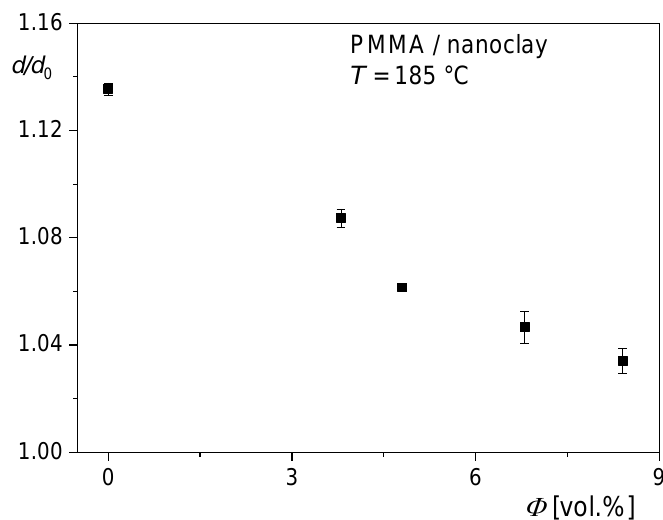
Figure 13. Extrudate swell 𝑑 𝑑 0 ⁄ of polymethylmethacrylate (PMMA) filled with nanoclay in dependence on the volume concentration ϕ at a wall shear stress of 90 kPa and 𝑇 = 185 °C. The diameter of the die was 𝑑 0 = 2.1 mm and its length 𝐿 = 8 mm. 𝑑 is the diameter of the strand completely annealed after extrusion [29].